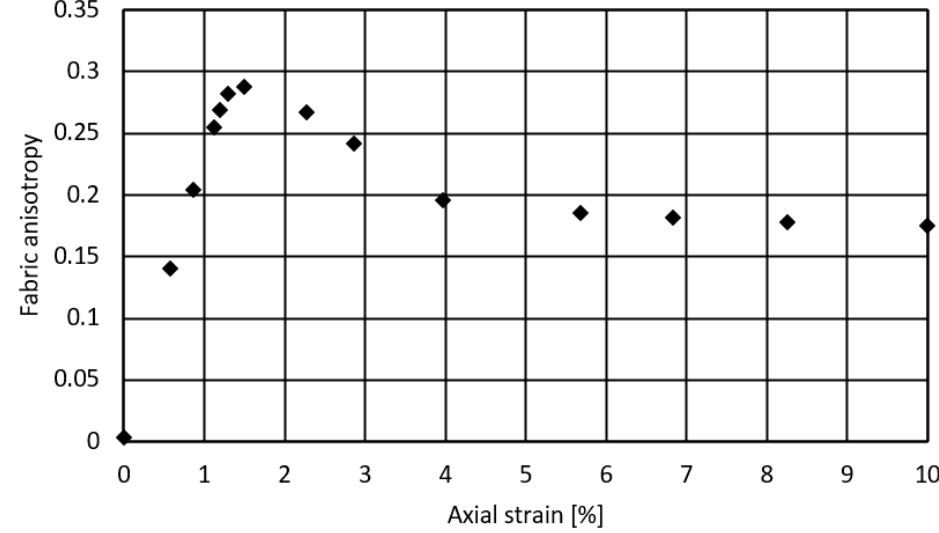
Figure 9. The variation of fabric anisotropy with axial strain.